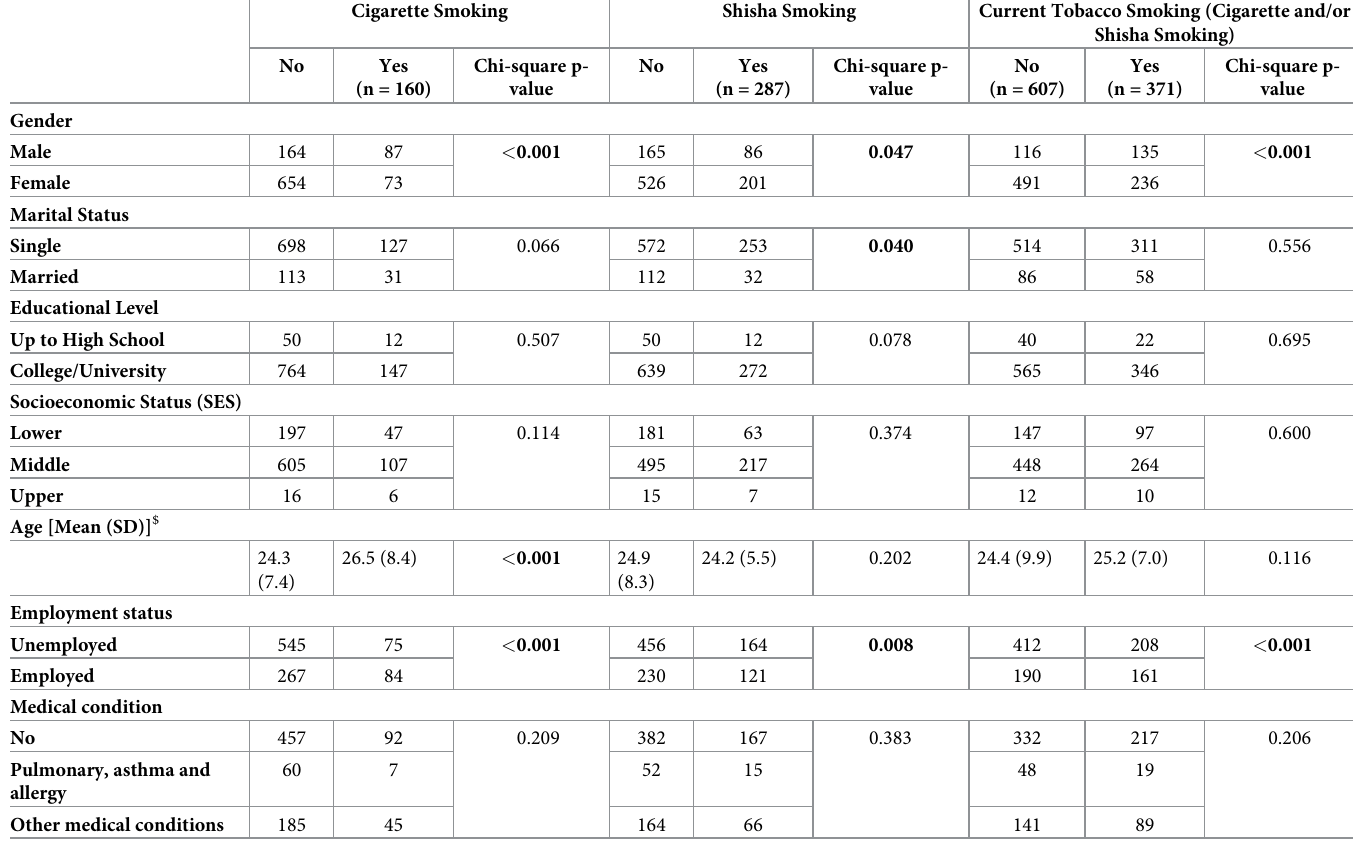
Table 2. Comparing smoking status of participants according to socio-demographic factors.